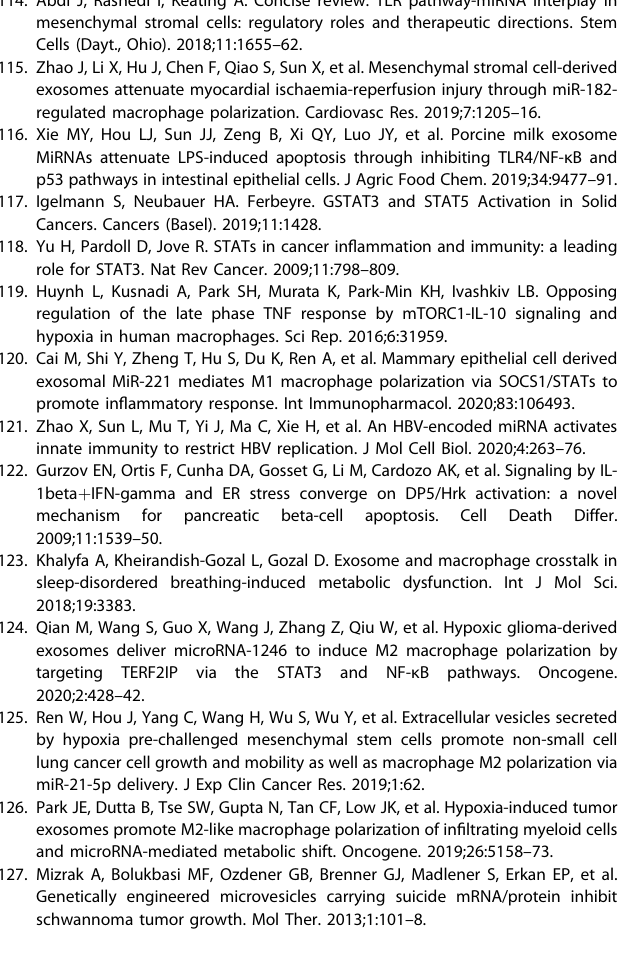
table. JT: design and conception, manuscript revising. YM: search of literature, language polishing. QZ: design and conception, revision, and supervision